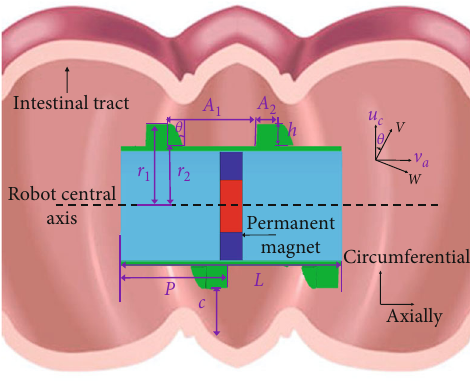
Figure 2: Capsule robot